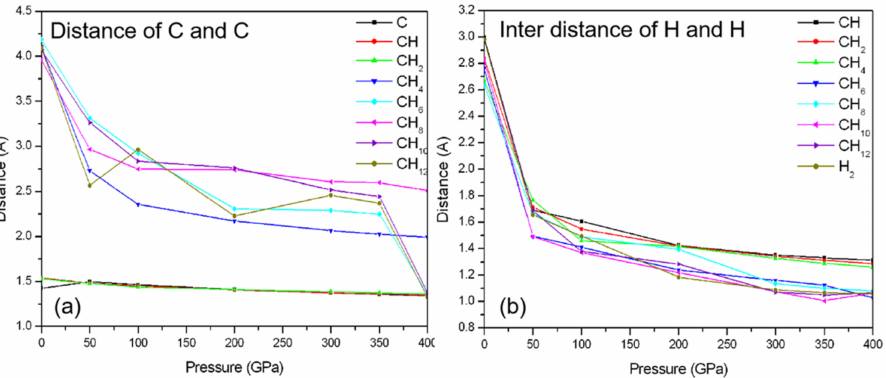
Figure 3. ( a ) the closest distance of C and C in CH n structures and carbon as a function of pressure. ( b ) the closest inter distance of H and H in CH n structures and H 2 as a function of